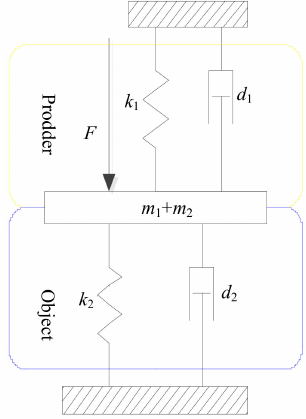
Figure 8. Mechanical model of one-degree freedom prodder-object